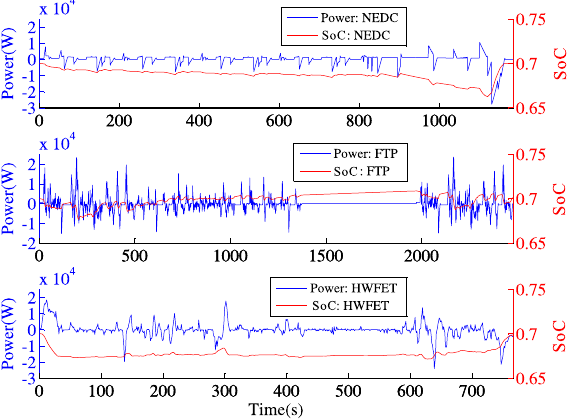
Figure 12. Battery output power and SoC under ( a ) NEDC, ( b ) FTP and ( c ) HWFET driving